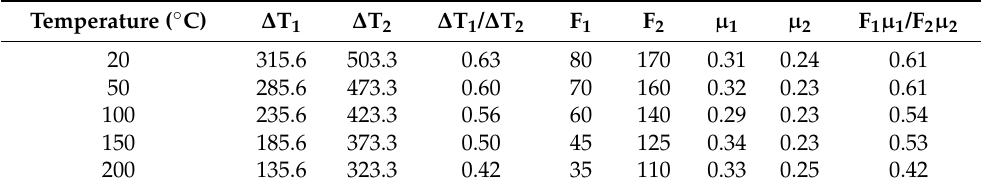
Table 4. Ratios of temperature increase and frictional force at mild–severe wear transition state and surface melting